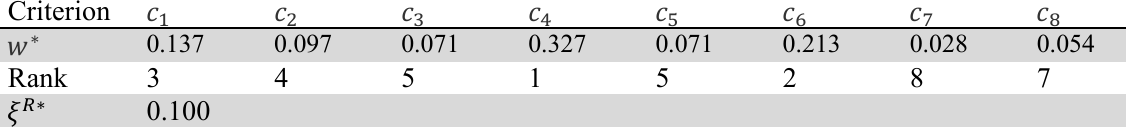
Weights and rankings of each criterion for the part 1 of example 4